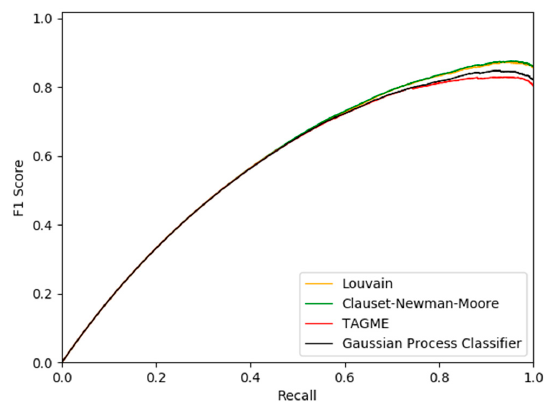
Figure 4. F1 score of the two community detection methodology variants, the Gaussian Process Classifier and TAGME baseline.